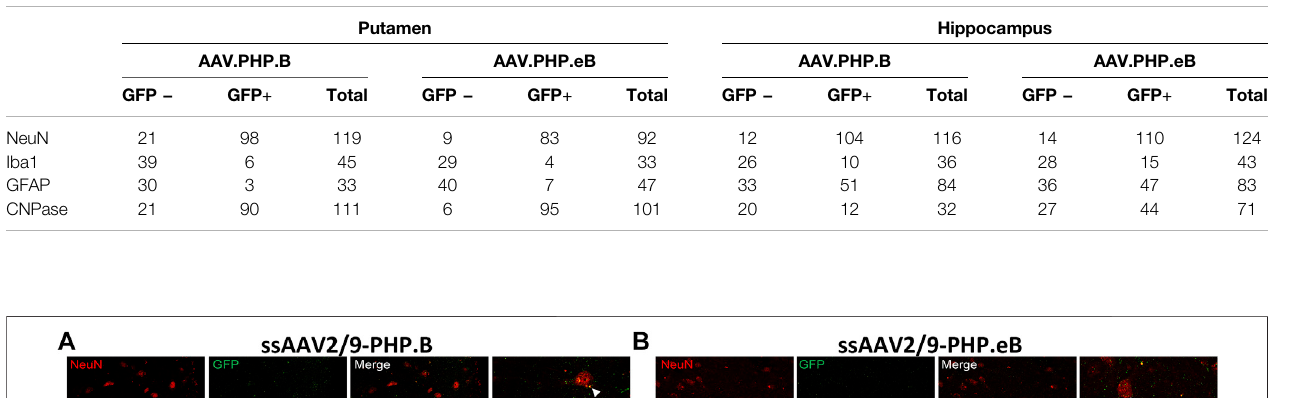
TABLE 2 | Quanti fi cation of putaminal and hippocampal cell type distribution.